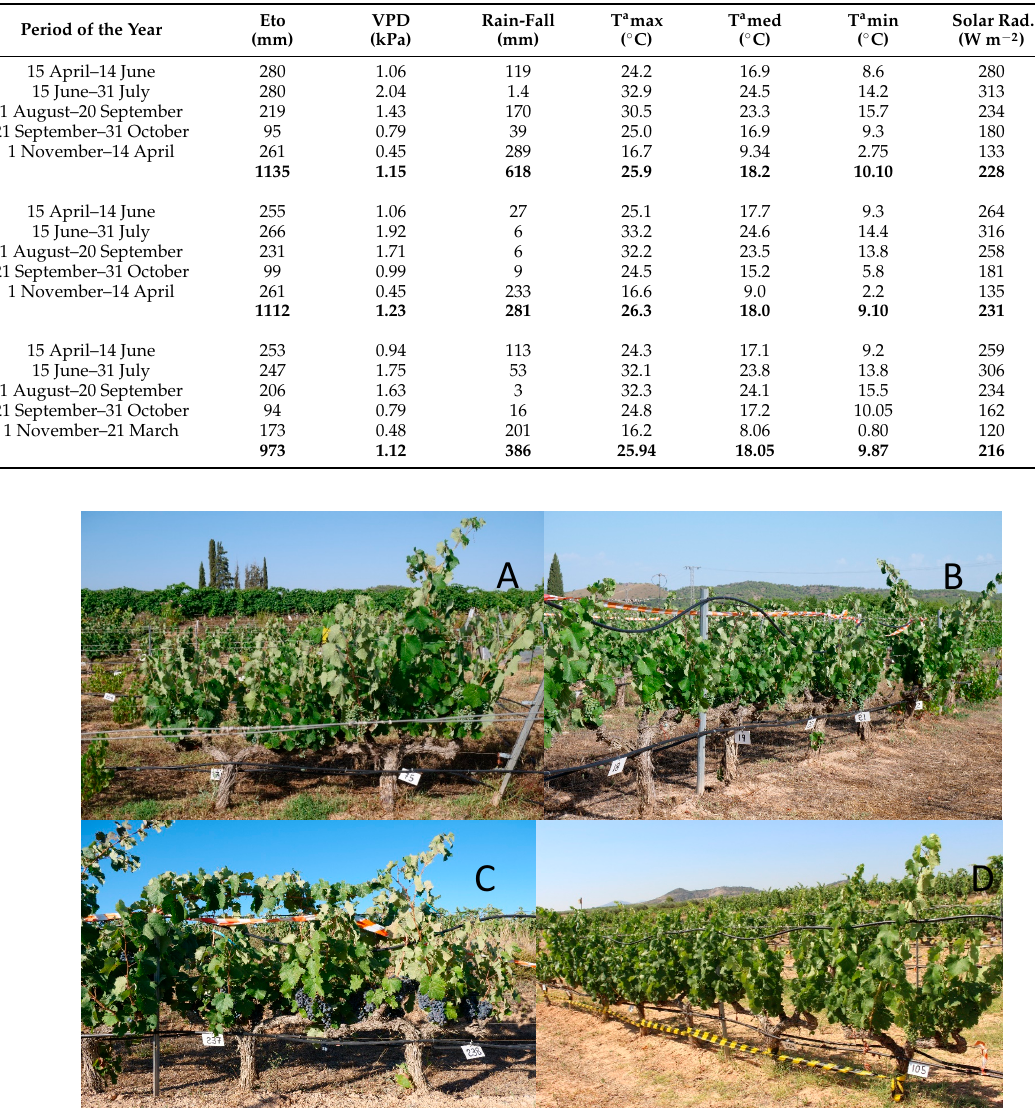
Figure 1. ( A ). Experimental vineyard showing Monastrell vines from clone 373 under control treatment in July 2020. ( B ). Monastrell vines from clone 360 under water stress in July 2020. ( C ). Monastrell vines from clone 4 under water stress in July 2020. ( D ). Monastrell vines from clone 372 under water stress in July